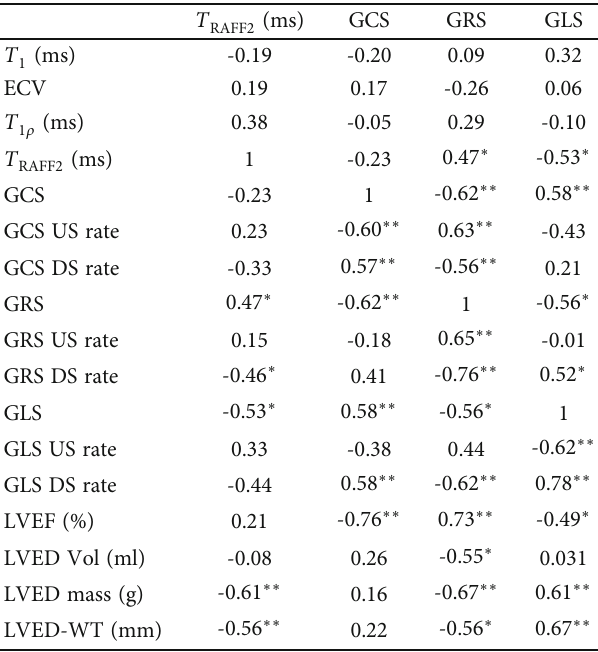
Table 1: Characteristics of HTN LVH patients and control group given as mean ± SD and global values (Student ’ s t -test).